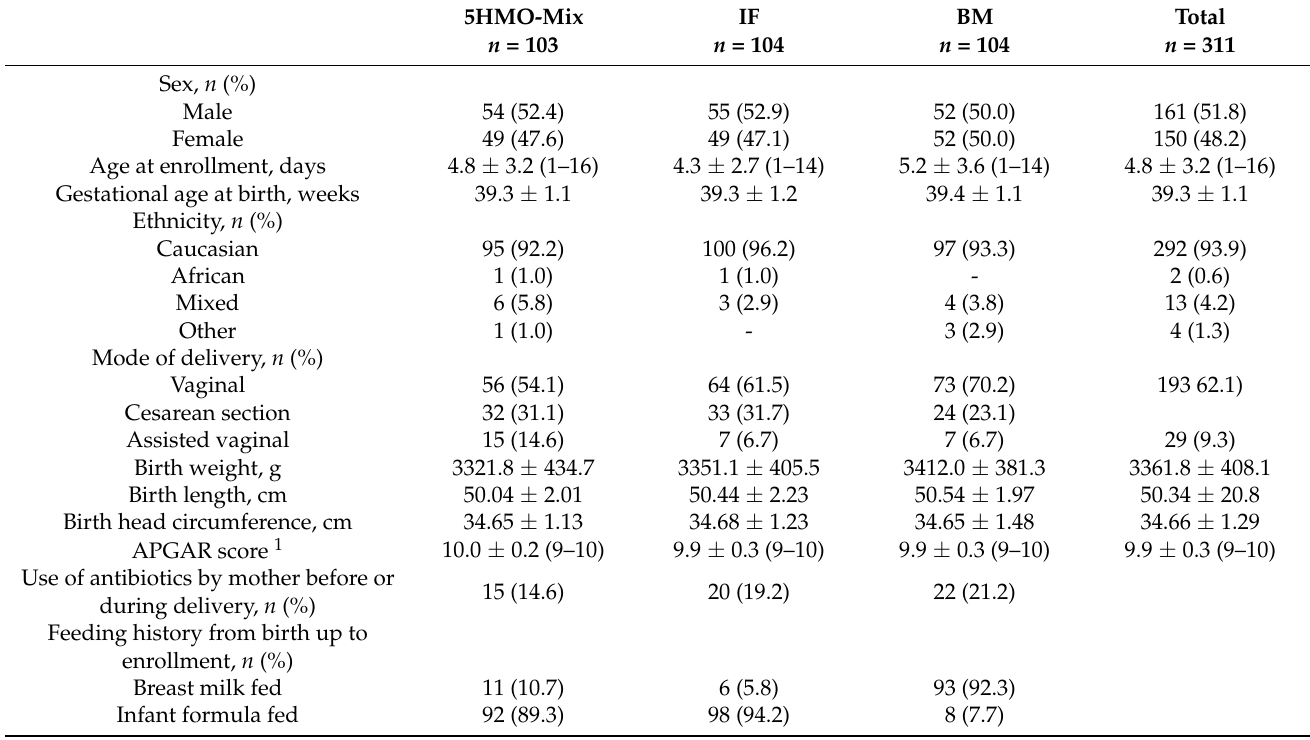
Table 2. Demographic and clinical characteristics of infants (safety set, n = 311).